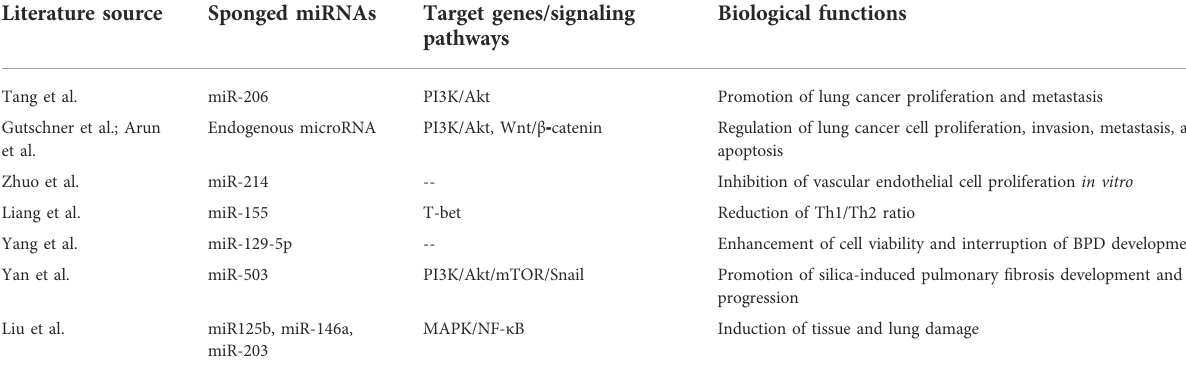
TABLE 3 MALAT1-mediated micro RNA regulatory networks in respiratory diseases.